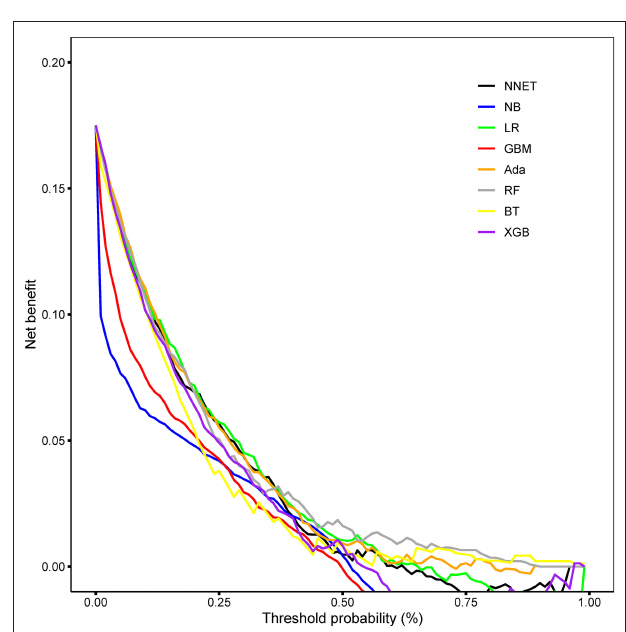
FIGURE 6 | Decision curve analysis of the eight models. NNET, artificial neural network; NB, naïve bayes; GBM, gradient boosting machine; Ada, adapting boosting; RF, random forest; BT, bagged trees; XGB, eXtreme Gradient Boosting; LR, logistic